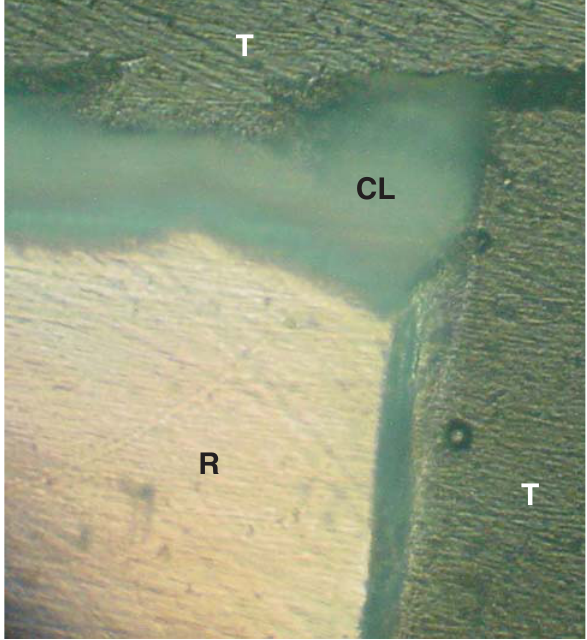
FIGURE 1- Polarized light microscopy indicating birefringent zones around restoration. Restoration (R), Caries lesion (CL), Tooth (T)